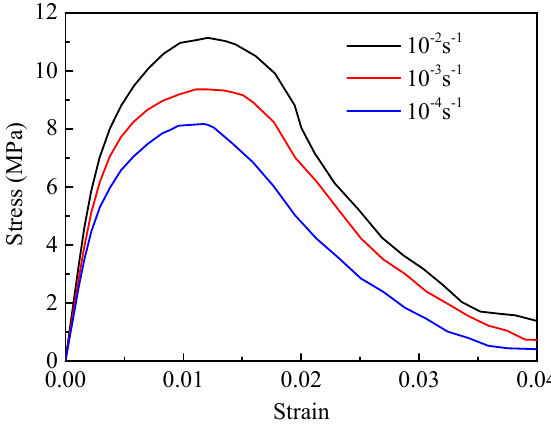
Figure 24. Compressive stress–strain curves of PBX 9501 at different strain rates.